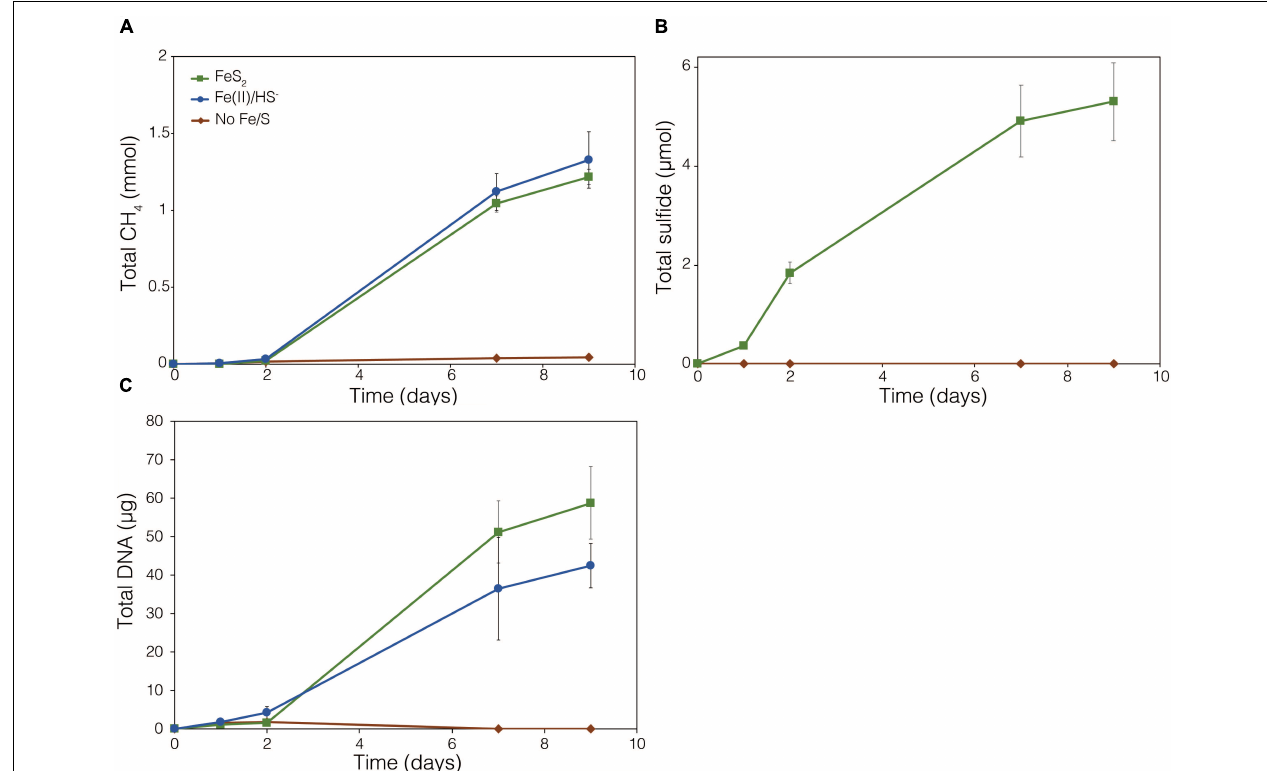
FIGURE 5 | Production of (A) methane (CH 4 ), (B) total sulfide (aqueous plus gas phase), and (C) total biomass (DNA) in cultures of Methanosarcina barkeri Fusaro with deletions in each of the four operons encoding all five [NiFe]-hydrogenases in its genome. The M. barkeri Fusaro hydrogenase mutant was grown either with no provided iron (Fe) or sulfur (S) source (No Fe/S); with 20 µ M ferrous iron [Fe(II)] and 0.4 mM sulfide (HS - ) [Fe(II)/HS - ]; or with 2 mM synthetic pyrite (FeS 2 ) nanoparticles as the sole sources of Fe and S. Hydrogen (H 2 ) was not detected (detection limit 0.1 µ M) in the headspace of any of the culture conditions tested (data not shown). Averages and standard deviations for triplicates are